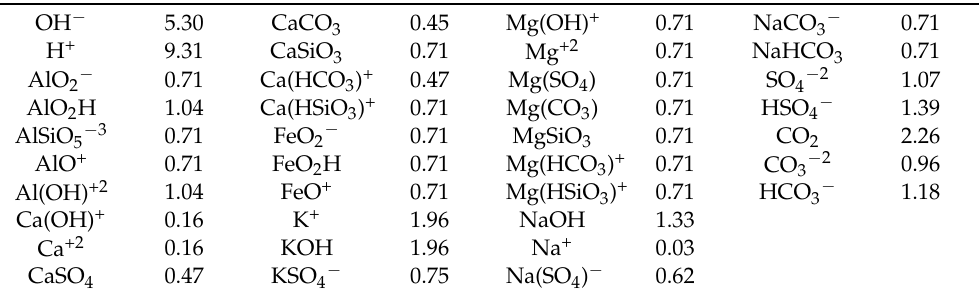
Table A3. Diffusion coefficients (Di × 10 − 9 ) of the ionic species included in the numerical example, after